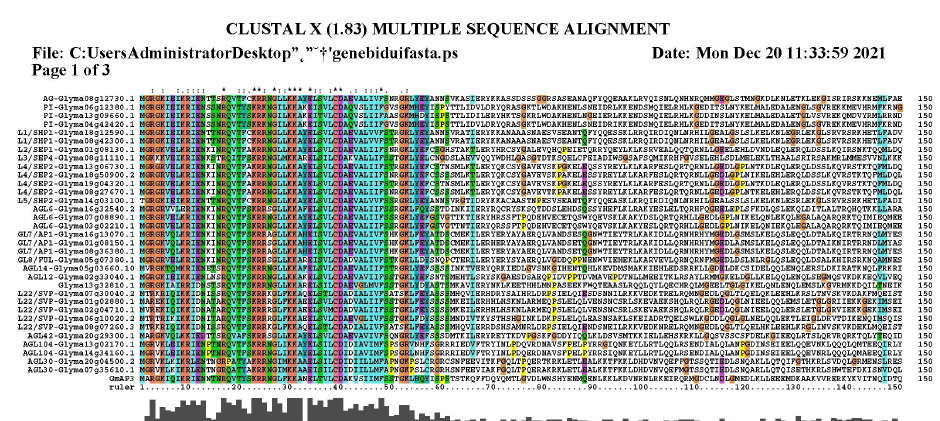
Figure 2. Comparative amino acid sequence analysis of 32 MADS-box gene families belonging to five categories of ABCDE based on MEGA7.0 and ClustalX. “*” indicates that all amino acid residues or nucleic acids in the aligned column are identical, “:” indicates that the column has a conservative substitution, “.” indicates that the column has a semi-conservative substitution.